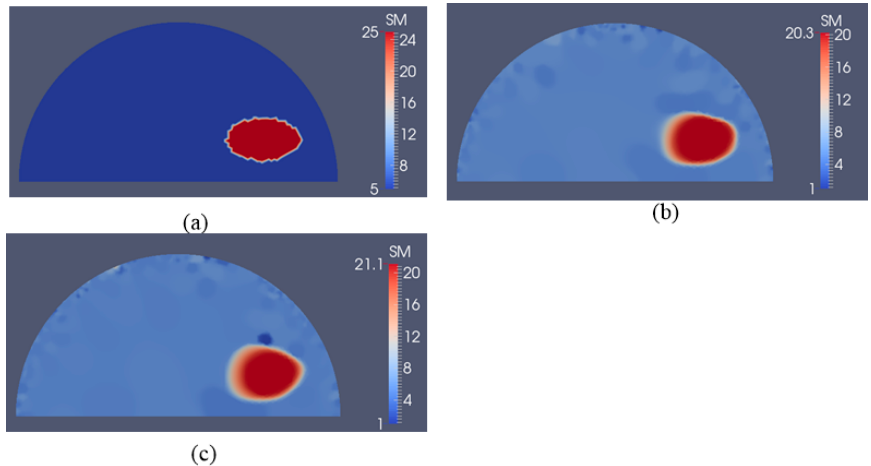
Figure 12. Shear modulus reconstructions with 0.1% noise. ( a ) target shear modulus distribution with an elliptic shaped inclusion is defined to study detectability of the inclusion shape; ( b , c ) reconstructed shear modulus distribution using 5 and 10 boundary displacement data sets, respectively (unit in the scale bar: kPa). Note: “SM” stands for shear modulus.